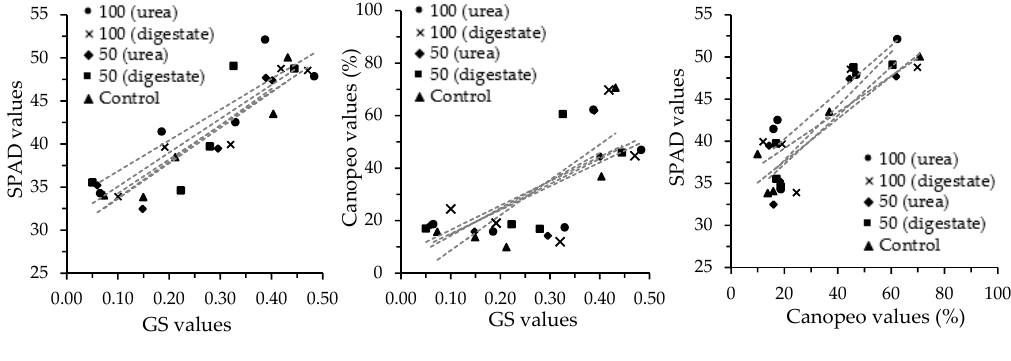
Legend: each treatment value corresponds to the average of three replicates Legend: units for GreenSeeker (GS) and SPAD-502 values are dimensionless Figure 5. Relationship between different POSs (SPAD-502, GreenSeeker, and Canopeo App.) and N fertilization treatments (100/50 kg N ha − 1 urea, 100/50 kg N ha − 1 digestate, and 0 kg N ha − 1 -control).